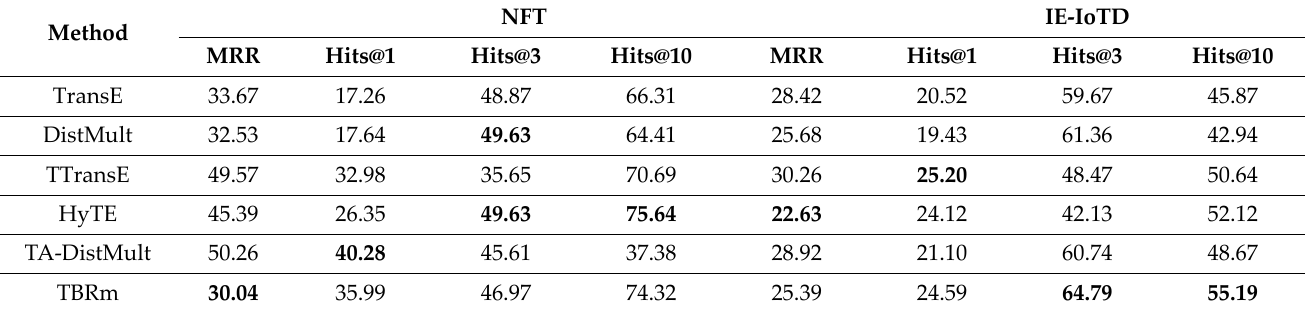
Table 4. Results (percentages) on the NFT and IE‑IoTD